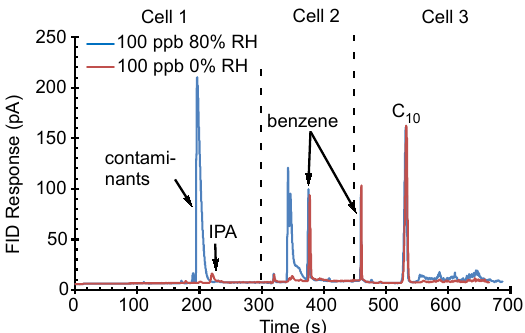
Figure 12. The PCA3mv chromatogram of IPA, benzene, and decane at 80% relative humidity and 0% relative humidity. The benzene and decane peaks in Cell 2 and Cell 3 showed minimal humidity